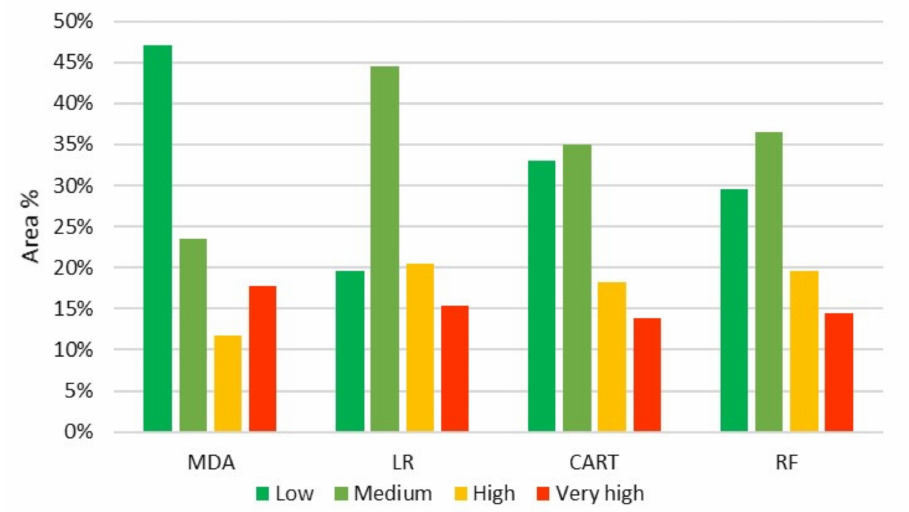
Figure 8. Percentage of area occupied by each susceptibility class determined by the four models over the study